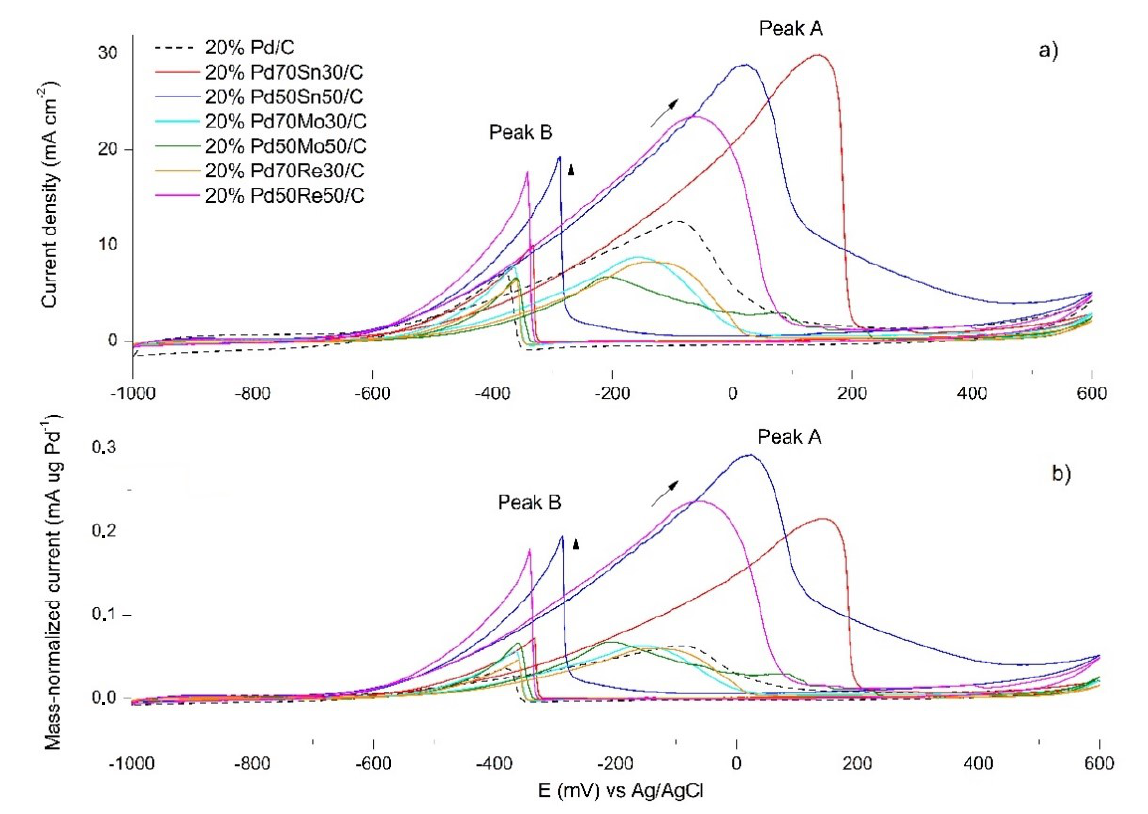
Figure 3. Cyclic voltammograms of 20% Pd/C, 20% Pd 70 Sn 30 /C, 20% Pd 50 Sn 50 /C, 20% Pd 70 Mo 30 /C, 20% Pd 50 Mo 50 /C, 20% Pd 70 Re 30 /C and 20% Pd 50 Re 50 /C in a solution of KOH 1.0 mol L − 1 + EtOH 1.0 mol L − 1 . ( a ) Current density (mA cm − 2 ) versus Voltage (mV); ( b ) Mass-normalized current (mA µ g Pd − 1 ) versus Voltage (mV). E (mV) vs. Ag/AgCl (3 M). (Scan rate: 50 mV s − 1 at room